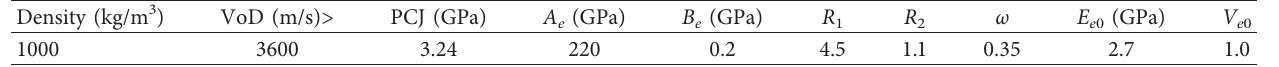
Table 2: Related parameters of No.2 rock emulsion explosive [32].